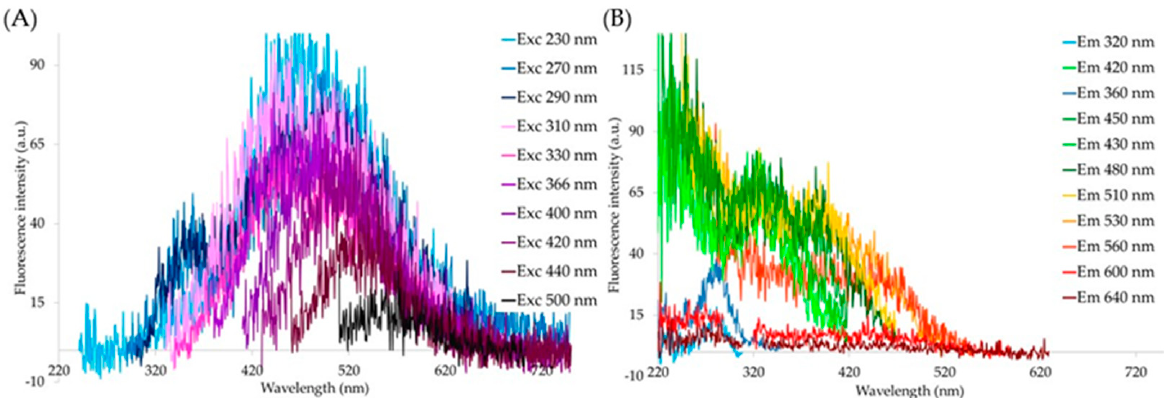
Figure 1. Emission ( A ) and excitation ( B ) spectra recorded from synthetic melanin in solution. Excitation and emission conditions are indicated by colors, on the right.